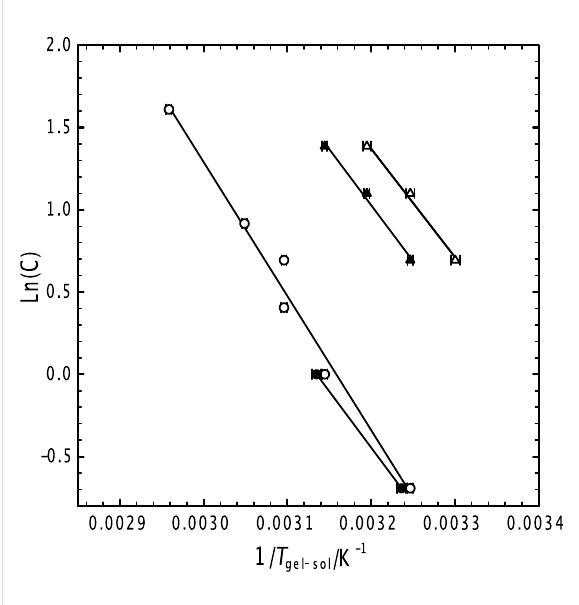
Figure 1: Schröder–van Laar analysis for the melting of toluene (open symbols) and ethanol/water (filled symbols) gels formed from G 6 (circles) and G 8 gelators (triangles).